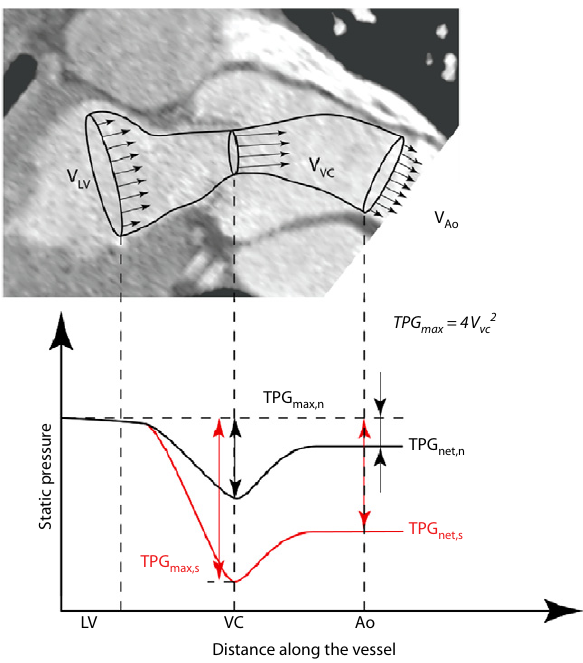
Figure.4 Transvalvularjetandconceptofenergyloss[75,81]superimposedtoalongitudinalsectionoftheaortic rootfromapatientwhohadundergoneanautograftreplacementoperation.LV:leftventricle,VC:venacontracta, Ao: aorta, TPG: transvalvular pressure gradient. Transvalvular pressure gradient becomes higher for stenosed aortic valve (red line) than for normal valve (black line) because of a high velocity jet through the stenosed valve accompanied by turbulent flow in the downstream causing high energy